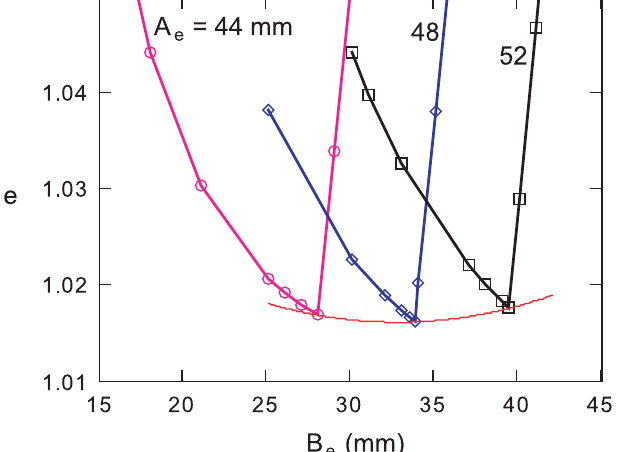
¼ and A for a e e e